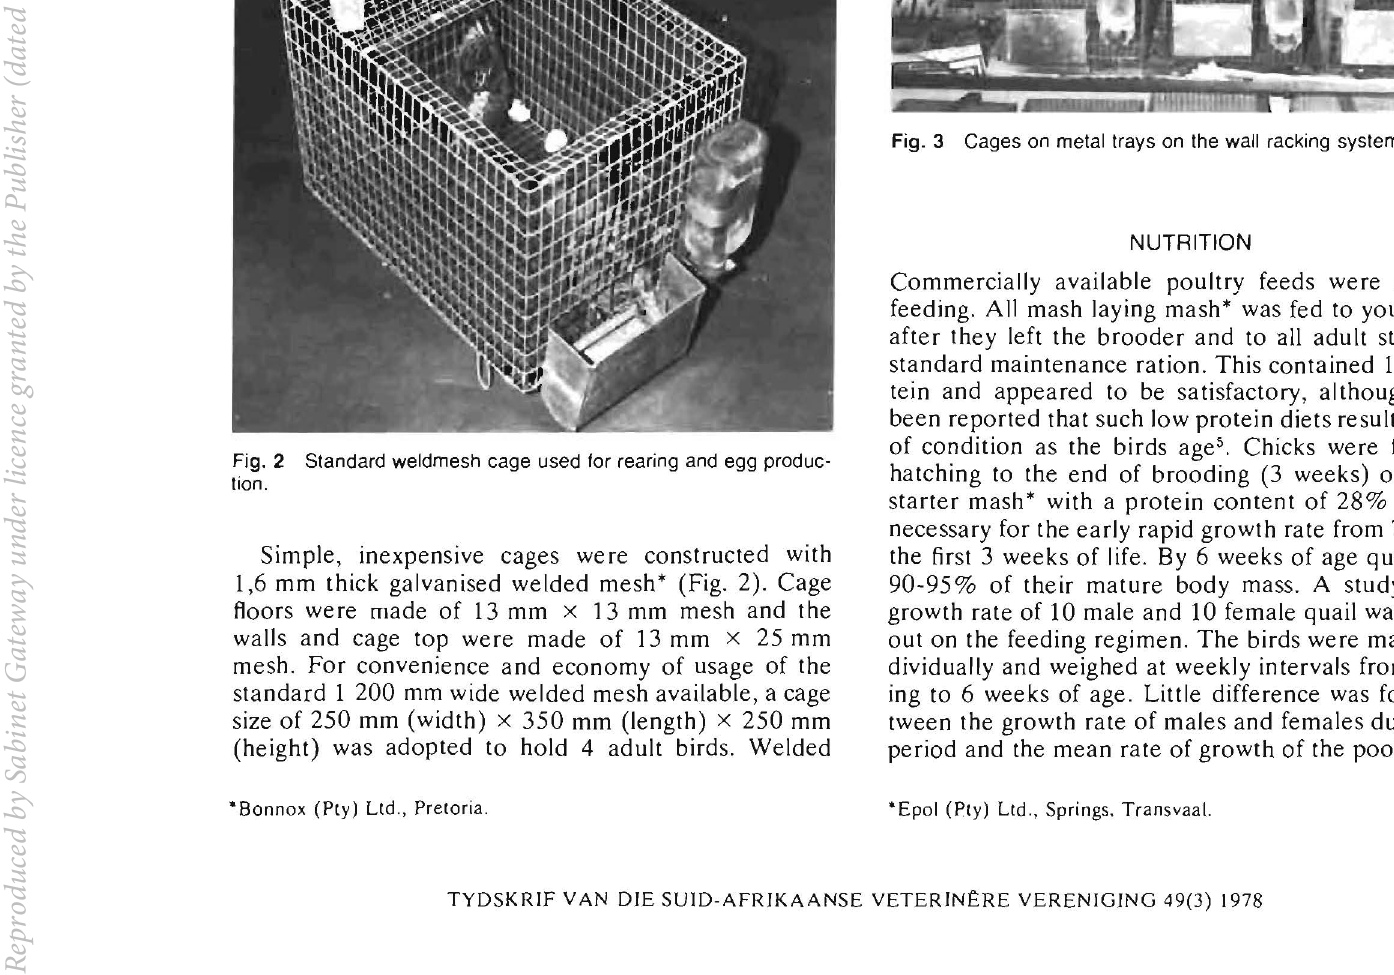
Fig. 3 Cages on metal trays on the wall racking